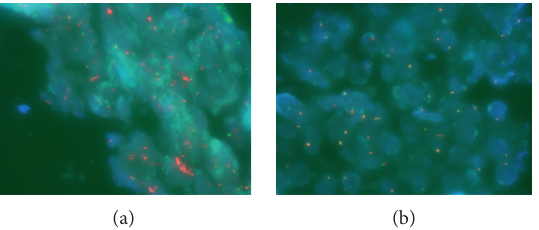
Figure 4: FISH analysis of the MYC of the bladder tumor (a) and nasal tumor (b). The split signal was detected in the bladder tumor, whereas no split signal was detected in the nasal